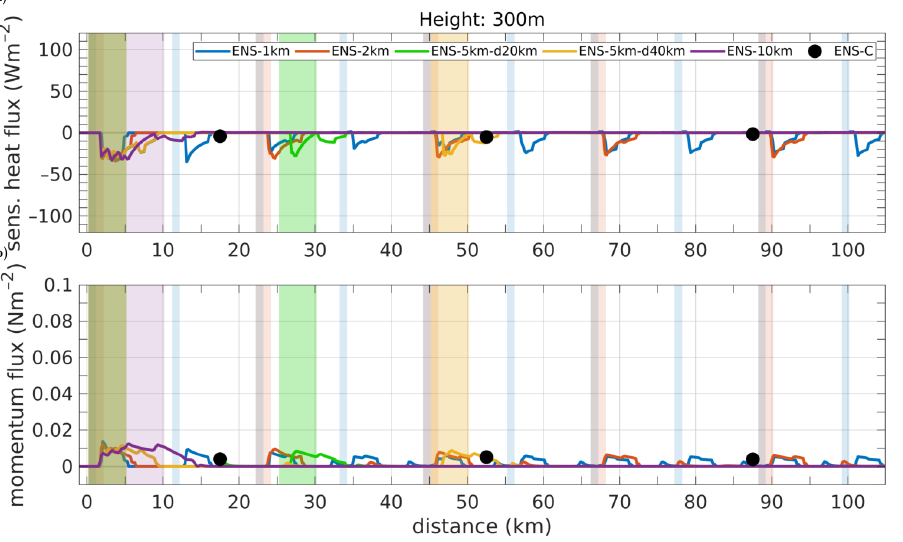
Figure 5. Same as Figure 4, but sensible heat and momentum fluxes at height z = 300m as a function of distance are shown. Modified based on Michaelis